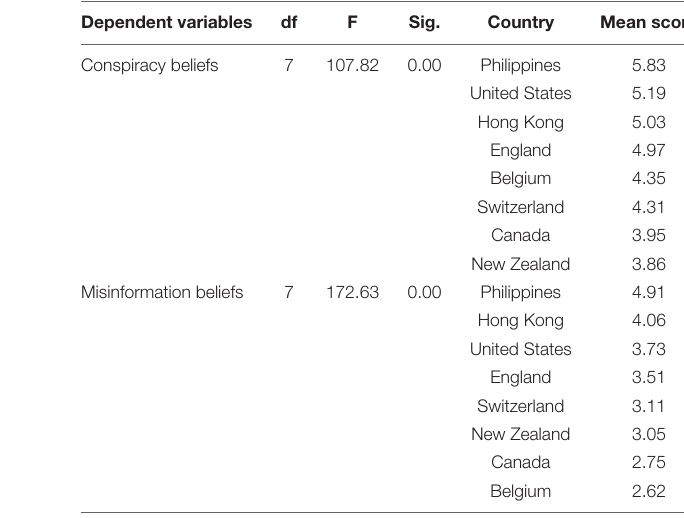
TABLE 3 | One-way ANOVA for country of residence on conspiracy beliefs and misinformation